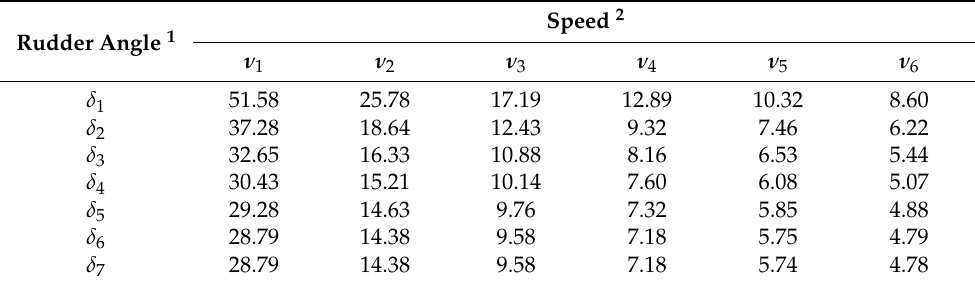
Table 2. Measured turning time of OS trajectory